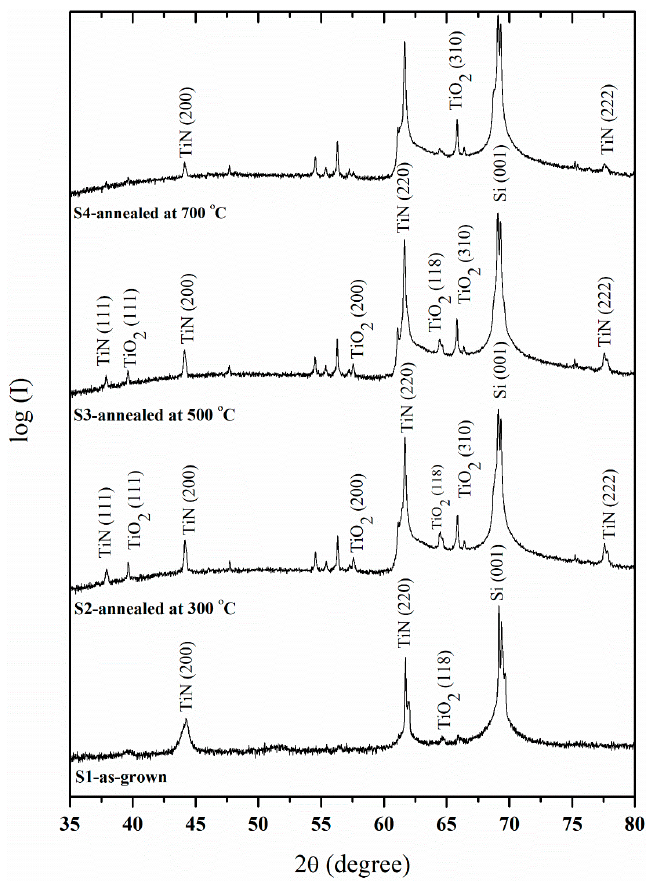
Figure 1. XRD scans of S1 (as-grown), S2 (annealed at 300 °C), S3 (annealed at 500 °C) and S4 (annealed at 700 °C) TiN thin films.